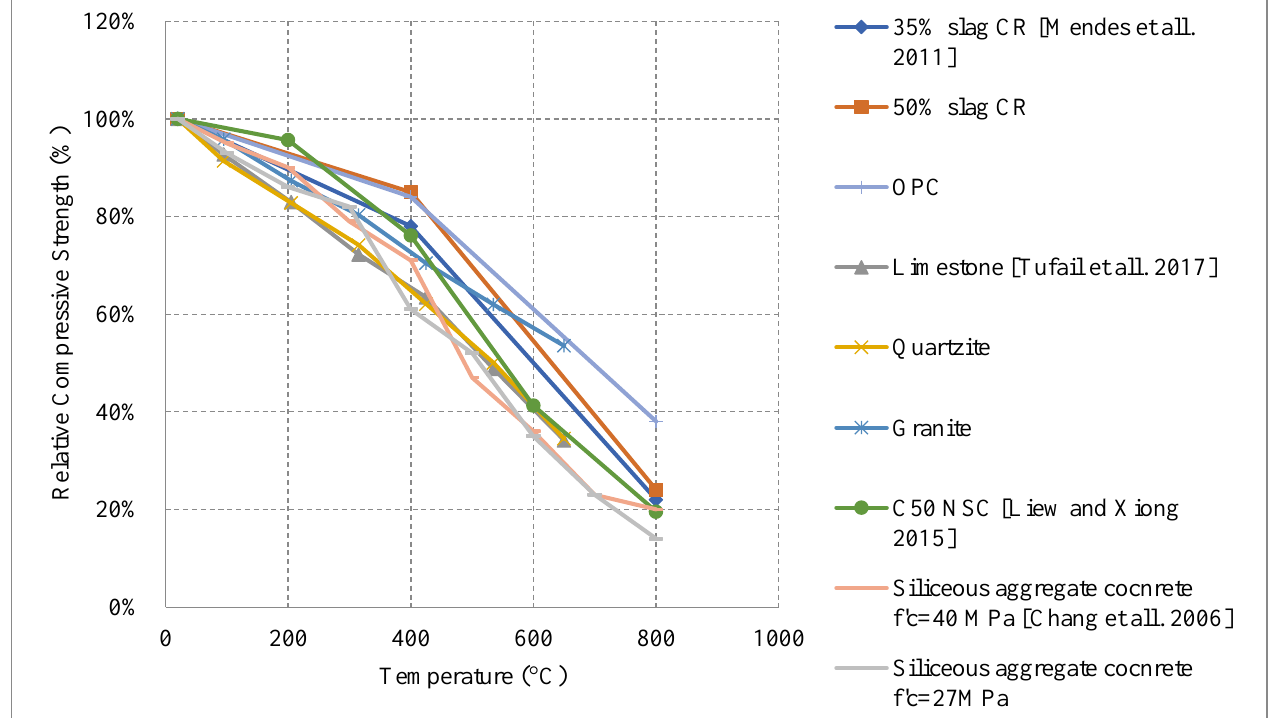
Figure 6. Effect of different constituents on the relative compressive strength of furnace cooled NSC. CR: Cement Replacement [45–48].